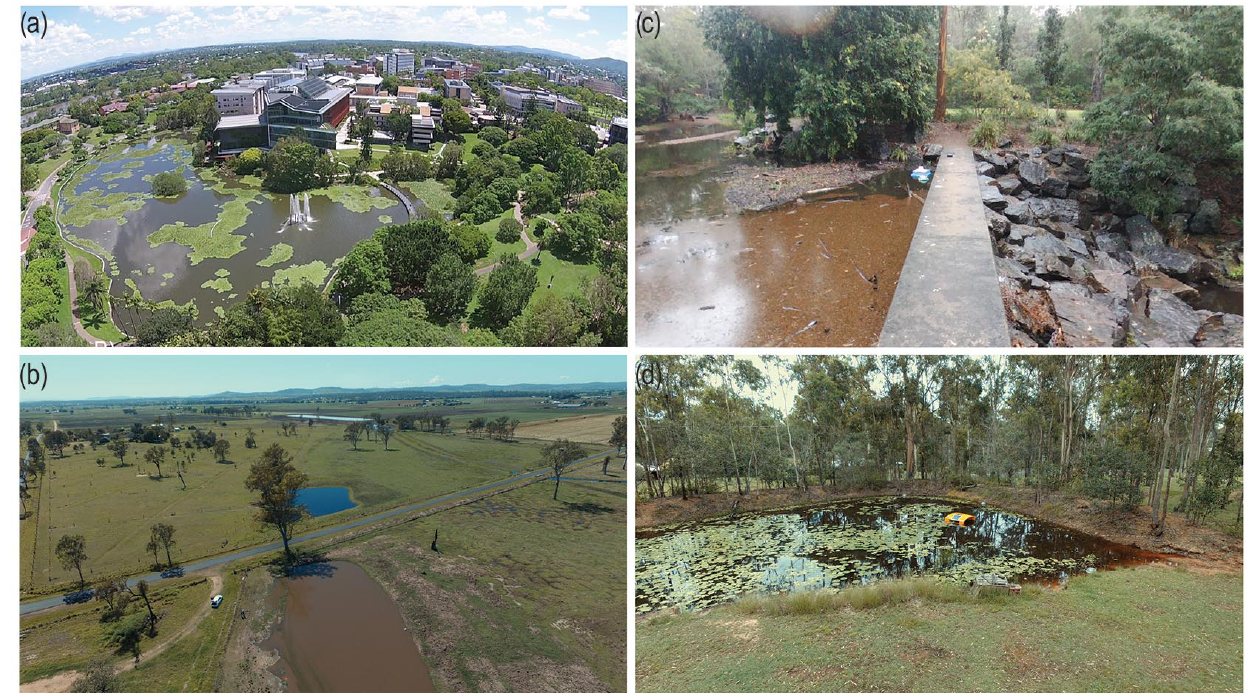
Figure 1. Oblique drone images showing examples of ponds where CH 4 emissions were monitored during this study: (a) urban lake (St Lucia 1); (b) stock dams in foreground (including Gatton 4), irrigation dam in background; (c) small weir showing high organic loading upstream of wall (Mt Coot-tha); (d) rural residential dam